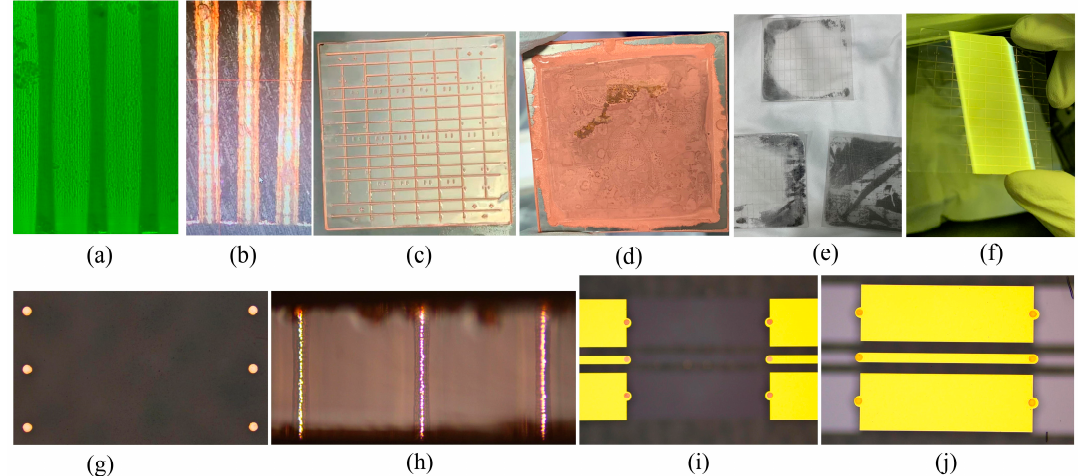
Figure 4. CPW TGVs test structure prototyping process. ( a ) laser-induced corrosion process, ( b ) deep-vias magnetron sputtering to prepare seed layer (copper) process, TGVs electroplating to fill copper process ( c ) front view and ( d ) bottom view, ( e ) grinding to remove surface copper layer process, ( f ) CMP process to obtain smooth TGVs filled with copper interposers ( g ) front-side view micrograph and ( h ) cross-sectional view micrograph, surface gold patterning process ( i ) front view and ( j ) bottom view.